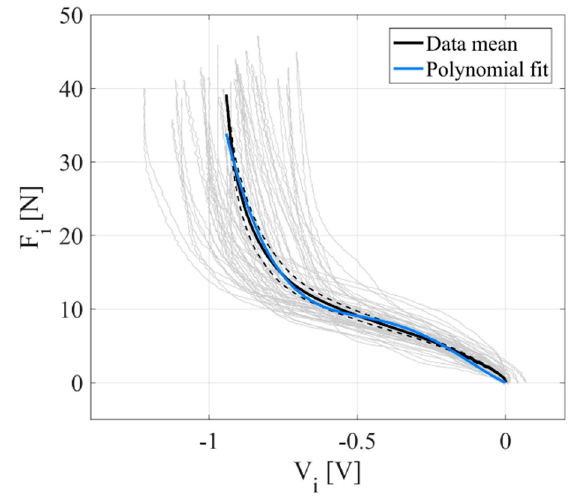
Figure 2. Tactel force-to-voltage relation. Experimental data from 32 sensors (grey); mean load–unload curves (dashed black) and overall mean curve (solid black); polynomial fit of the overall mean curve (blue).